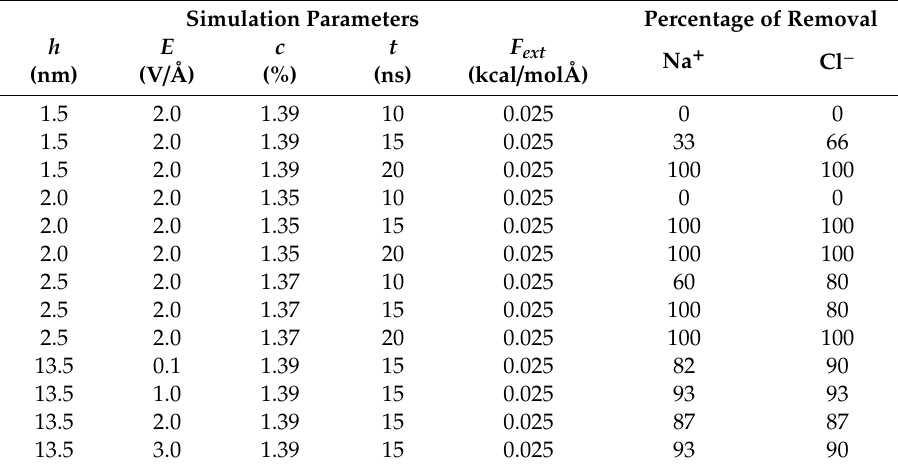
Table 3. Numerical results for every simulation